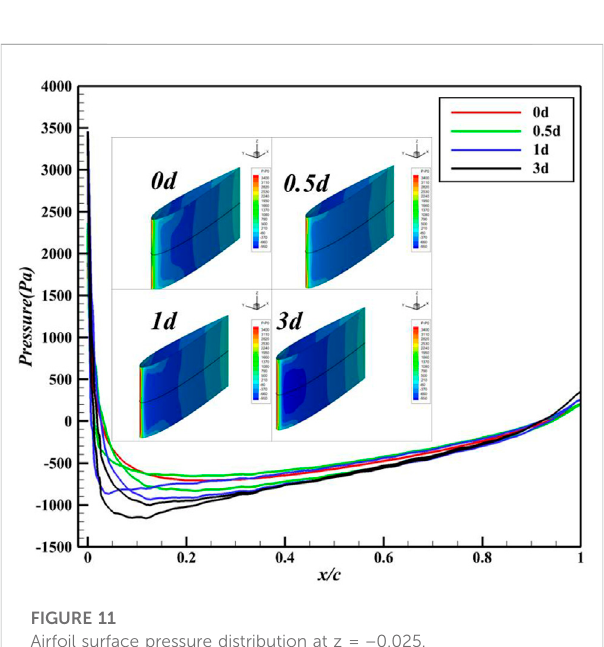
a non-linear decreasing trend, and the offset distance has less